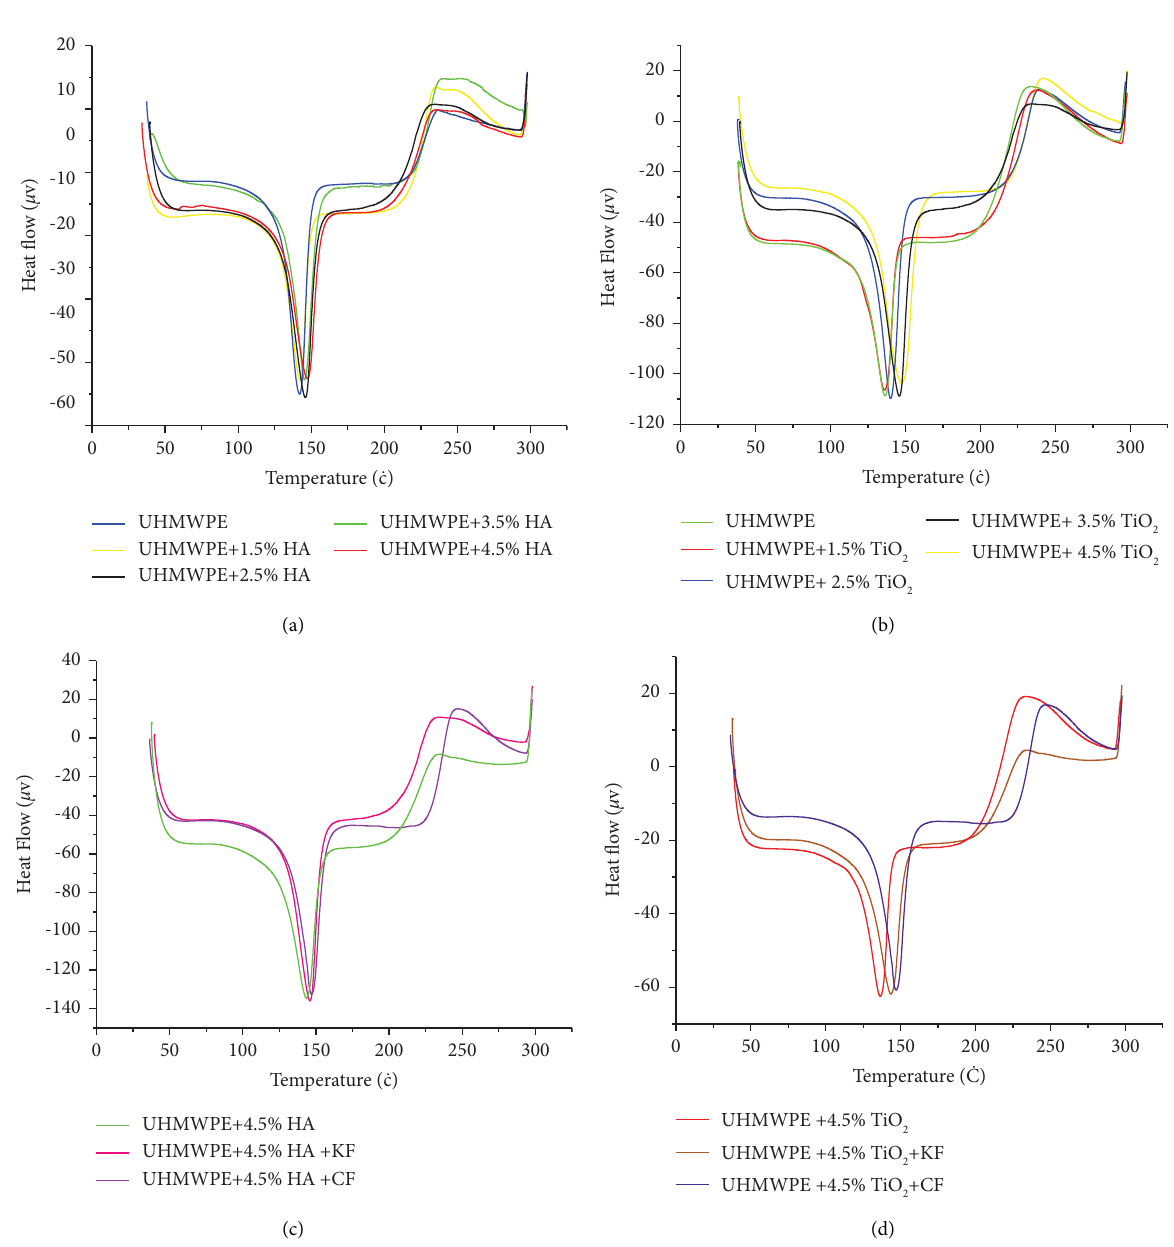
Figure 2: DSC analysis for (a) particulate biocomposite with hydroxyapatite NPs, (b) particulate biocomposite with titanium oxide NPs, (c) hybrid biocomposite with hydroxyapatite NPs, and (d) hybrid biocomposite with titanium oxide